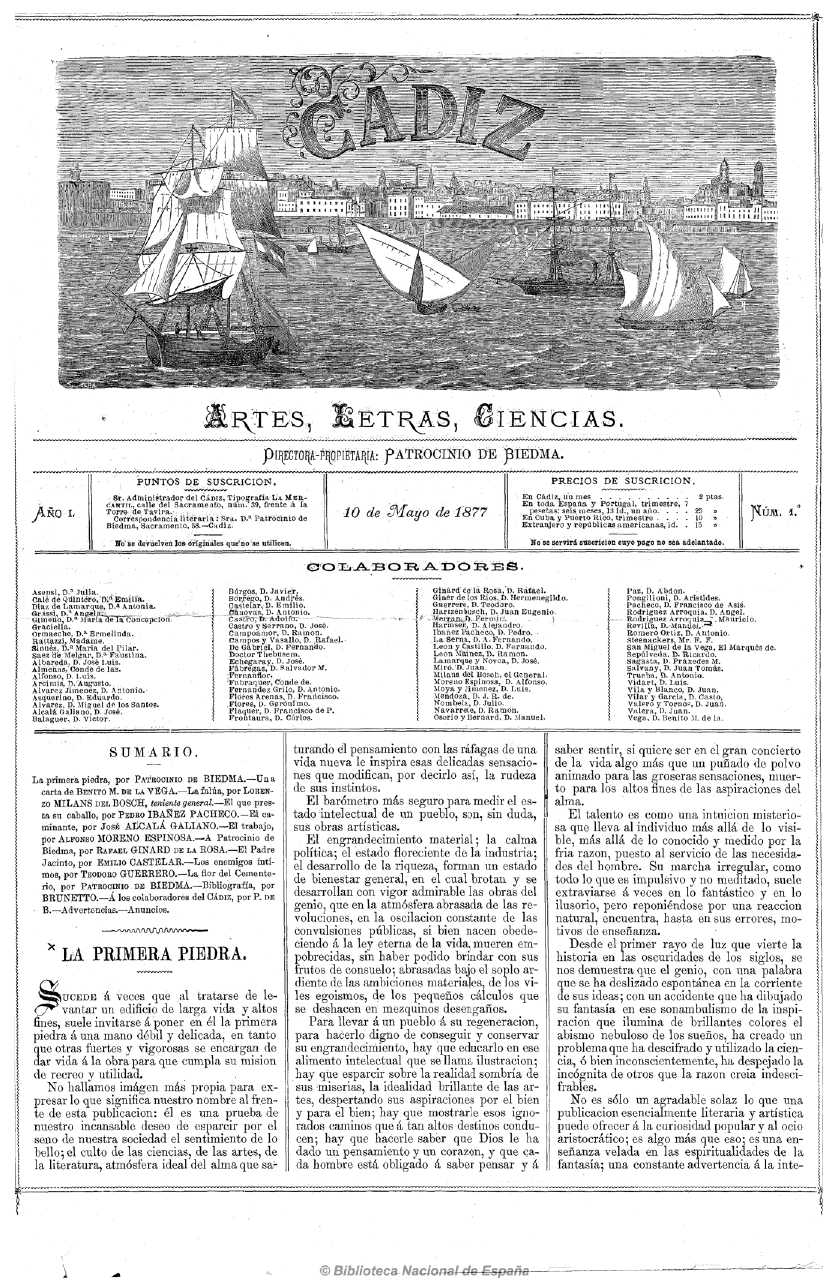
Fig. 2 Front page of Cádiz (10 May 1877), edited by Patrocinio de Biedma (1858‒1927). Hemeroteca Digital, National Library of Spain bargain for advertising contracts; her active search for subscribers, associates, and benefactors; and her decision to move from Cádiz to Madrid, the intellectual centre of the Spanish-speaking